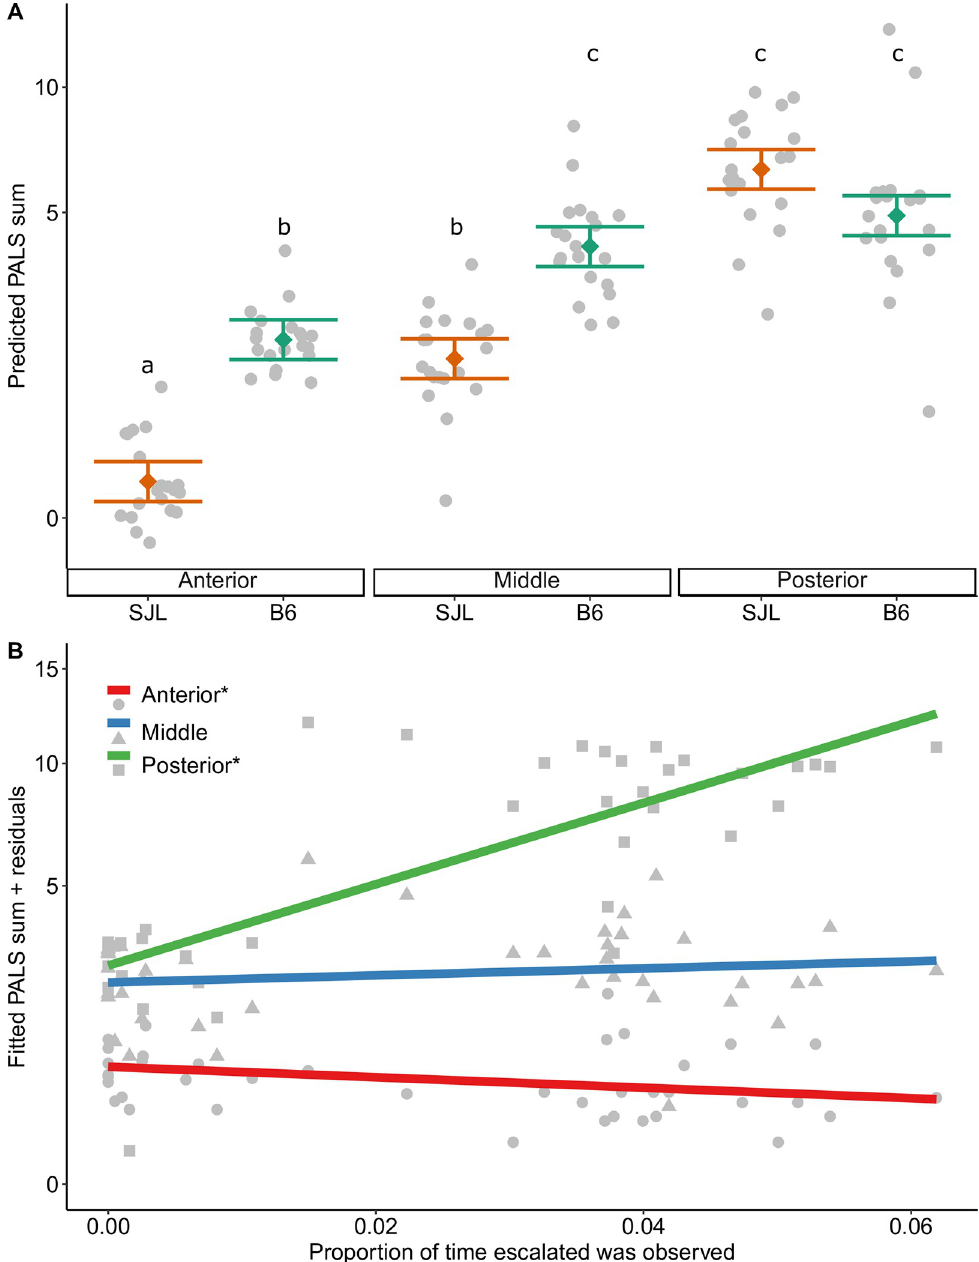
Fig 3. Wounding was impacted by (A) a strain x PALS region interaction and (B) a PALS region x proportion of escalated aggression interaction (R adj2 = 0.90, N = 120). Data are presented as factor level LSM ± SE with the scatter of individual residual error points in panel A. Significant post hoc comparisons are indicated by differing letters within each panel. In panel B, data are presented as the best fit line per PALS region over a scatter of individual residual error points. Slopes that significantly differ from zero are marked by an “ � ” in the legend. Y axes are shown on a square root back transformed